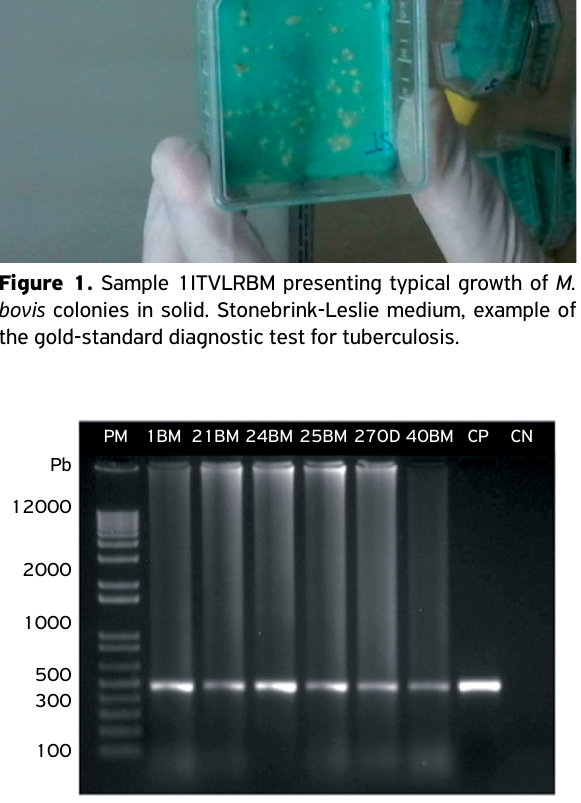
Figure 2. Agarose gel showing bands corresponding to M. bovis . The amplification was performed using DNA extracted from tuberculosis‑like lesions. PM: molecular size pattern 1kb Plus DNA Ladder (Invitrogen). CP: positive control. CN: negative control.